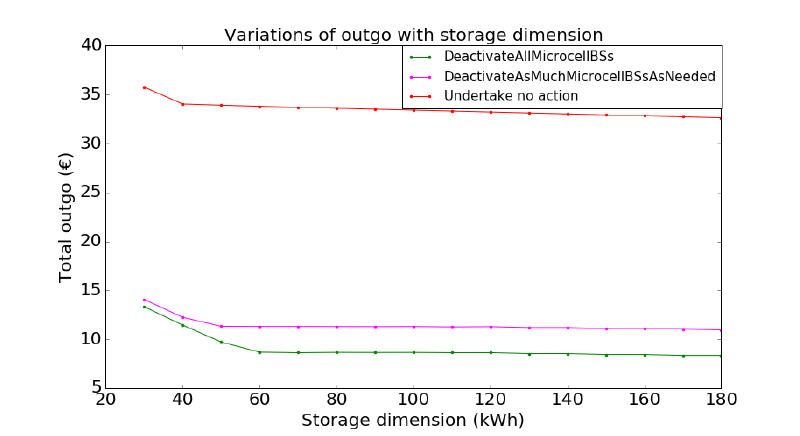
Figure 10. Buy in advance : effects of storage dimension variation on the total